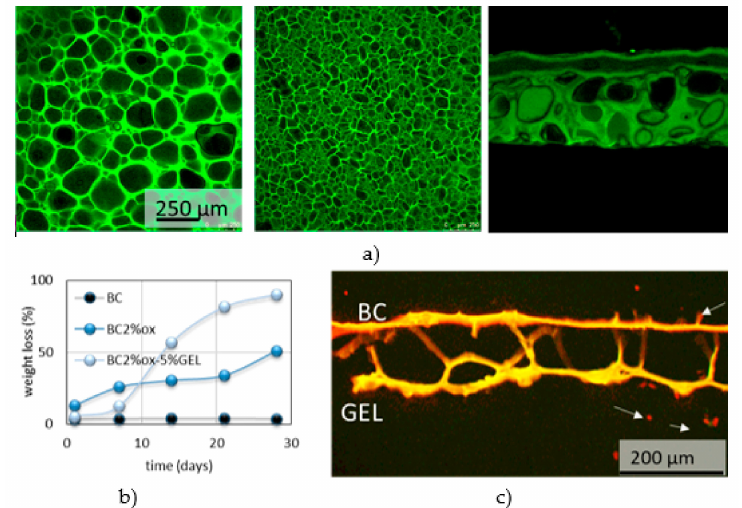
Figure 9. ( a ) Fluorescent microscopy images of top, bottom and cross-section aspect of BC-gelatin composite membranes; ( b ) their degradation kinetic; ( c ) barrier e ff ect towards MRC-5 cells. Adapted from [92], with permission from Nanomaterials,